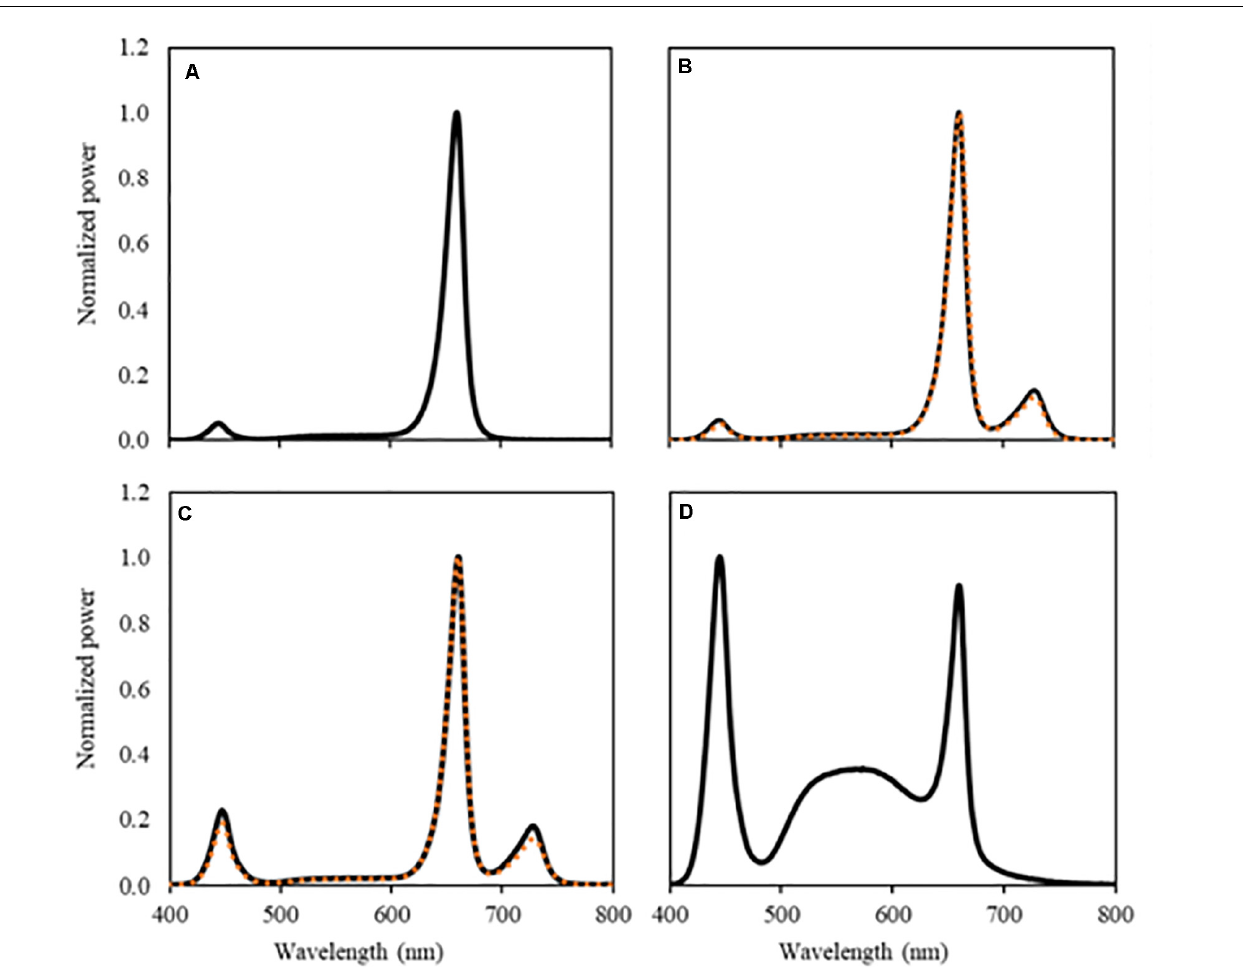
FIGURE 1 | Spectral composition of the light treatments, UV-B light excluded. (A) RWB, (B) RWB FR (orange dotted line) and RWB + FR (black solid line), (C) RWhB FR (orange dotted line) and RWhB + FR (black solid line), and (D) White provided by the LEDs measured at the top of the canopy.